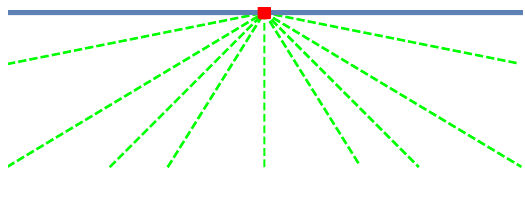
Figure 3 . Surfaces of constant r in AdS 3 , denoted by green dashed lines. The horizontal line on top is the asymptotic boundary of AdS , and the red dot is the interface. Lines of constant Poincaré 3 Patch radial coordinate would correspond to horizontal